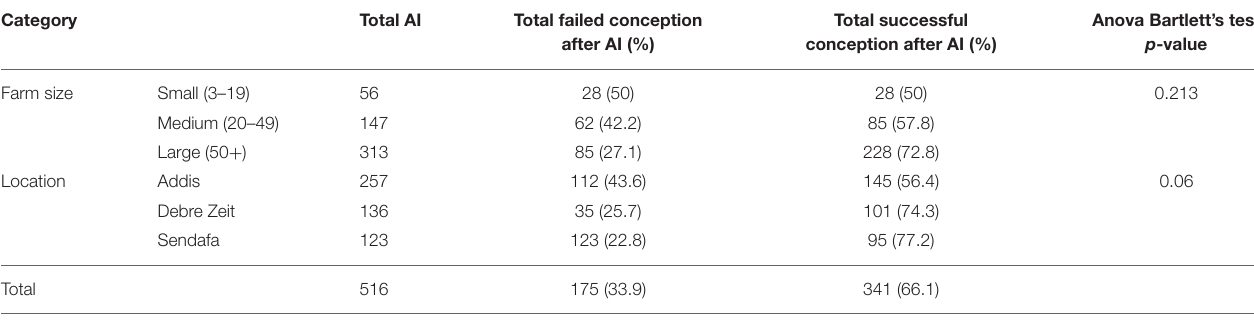
TABLE 5 | Number of successful AIs by farm size category and geographical locations. Category